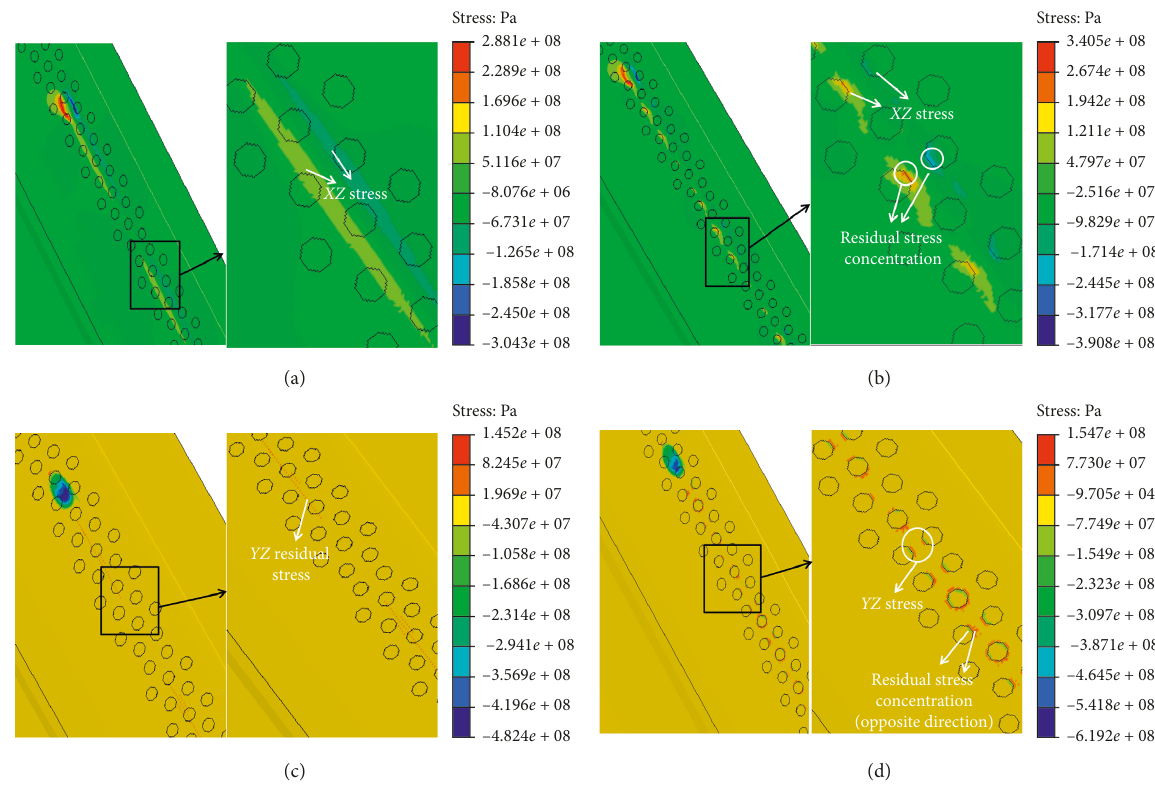
Figure 14: Field of shear stress on the rail: (a) xz stress with nonhardening material; (b) xz stress with hardening material; (c) yz stress with nonhardening material; (d) yz stress with hardening